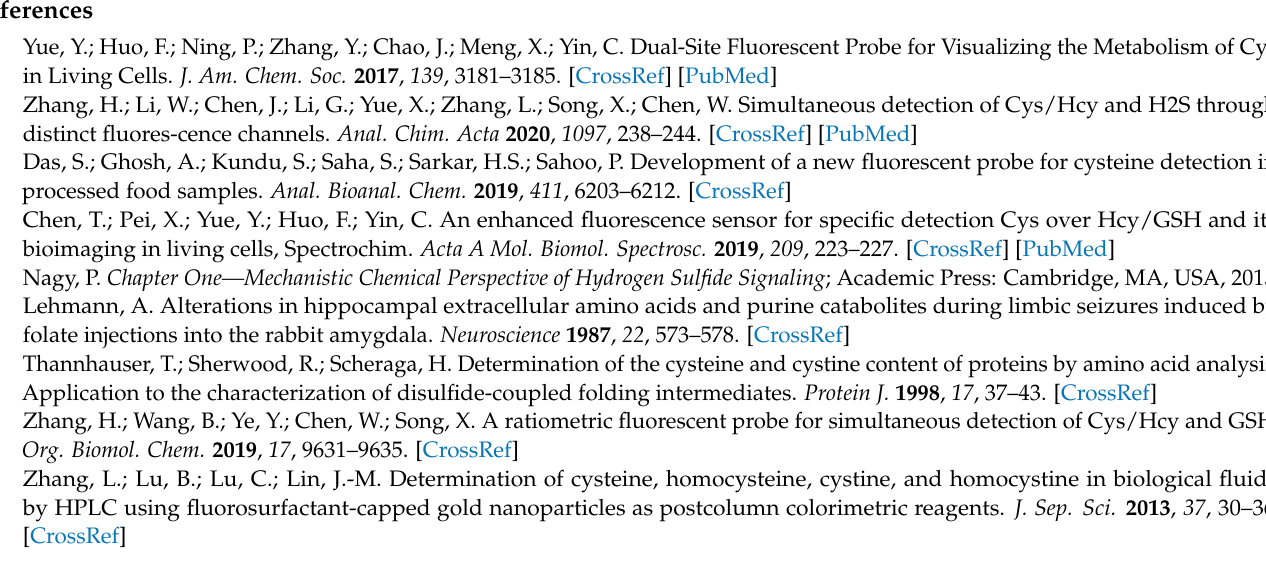
Figure S1. The proposed system for Cys measurement. (A). The self-designed FPGA card to drive Class III laser diode and to amplify PA signals; (B). The tube placed on top of the ultrasound transducer to correct PA signals; Figure S2. FT-IR spectra includes pure L -cysteine (green line) and as-prepared Au NRs (red line) and Au@Cys NRs (blue line). The IR band at 2850 and 2915 cm − 1 are assigned to C-H stretching and around 3176 cm − 1 and 3440 cm − 1 are associated with asymmetric stretching of OH groups for Au NRs. For L -cysteine, the characteristic FT-IR peak of absorption peaks at 1392 cm − 1 and 1577 cm − 1 are assigned to asymmetric and symmetric stretching of COO - respectively. The peak at 1535 cm − 1 and 2549 cm − 1 are attributed to N-H stretching and S-H stretching. The spectrum of Au@Cys NRs exhibited the N-H band is shifted to 1586 cm − 1 because L -cysteine is modified on Au NRs and the S-H band is dispersed which converted to a strongly Au-S bond; Figure S3. FT-IR spectra of pure L -cysteine (green line), as-prepared Au NPs (red line) and Au@Cys NPs. The peaks at 1388 cm − 1 and 1561 cm − 1 are assigned to asymmetric and symmetric stretching of COO - and is slightly shifted in the Au@Cys NPs condition. Then, the vibration curve of N-H band in Au@Cys NPs is shifted to 1578 cm − 1 because of the L -cysteine conjugation onto Au NRs. Also, the S-H bond in the L -cysteine is dispersed which converted to a strongly Au-S bond; Figure S4. The XPS spectrum of Au 4f core-level of (A) Au NRs and (B) Au@Cys NRs; Figure S5. The UV-Vis absorbance spectrum and TEM images (insert) with four Cys concentrations (0 µ M (pure Au), 10 µ M, 100 µ M and 1000 µ M) of (A) Au@Cys NPs and (B) Au@Cys NRs after 520 nm and 650 nm laser irradiation within 4